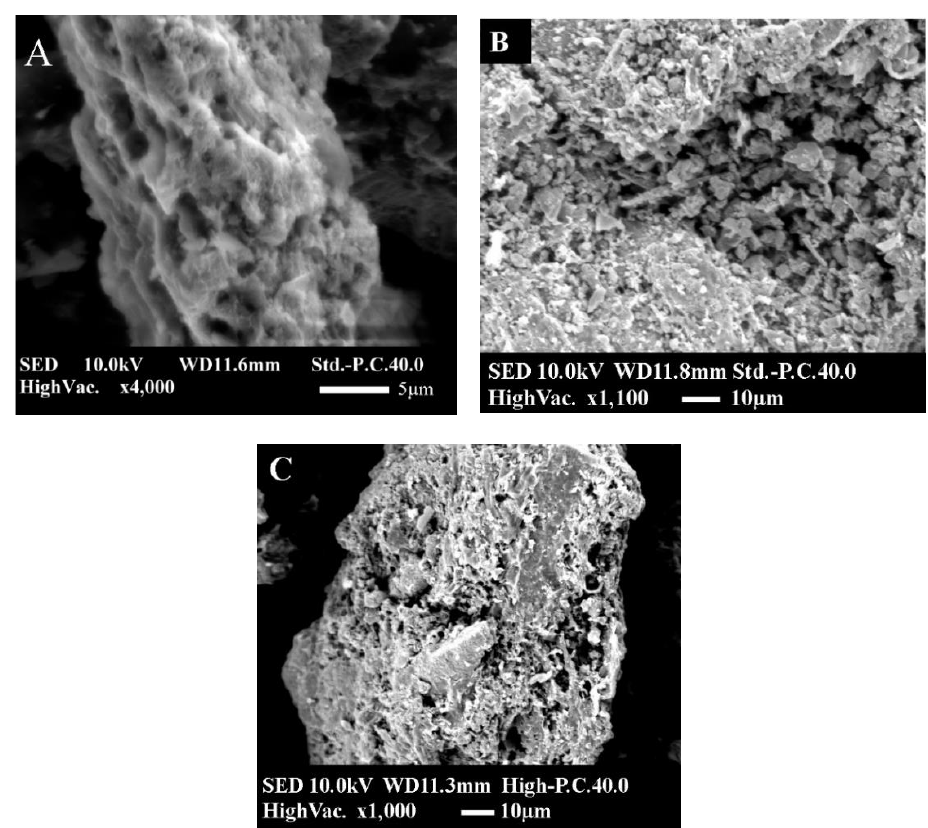
Figure 4. SEM images of SMC. ( A ) Pristine compost, ( B ) SMCB/Fe before nitrate adsorption, and ( C ) SMCB/Fe after nitrate